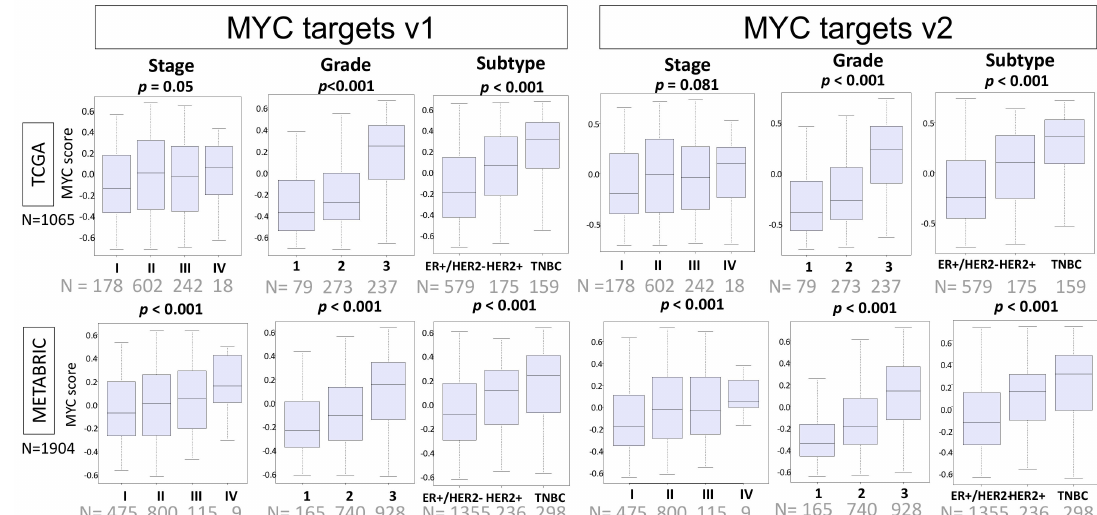
Figure 2. Association of the MYC score with clinical and pathologic features. Boxplots showing high and low MYC v1 and v2 scores in TCGA and METABRIC cohorts compared in American Joint Committee on Cancer (AJCC) cancer stage, Nottingham pathologic grade, and breast cancer subtypes. One-way ANOVA was used for the